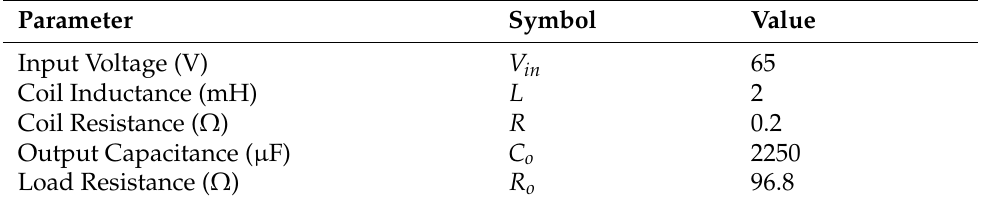
Table 1. Parameters from the converter control simulation.